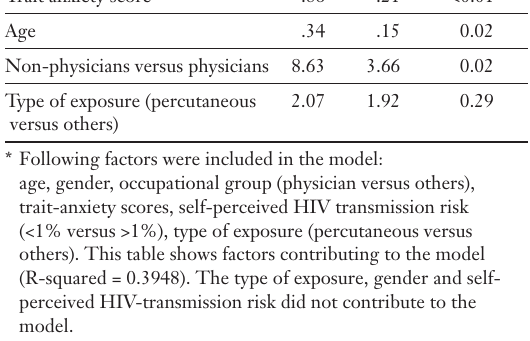
Multiple regression- state anxiety.